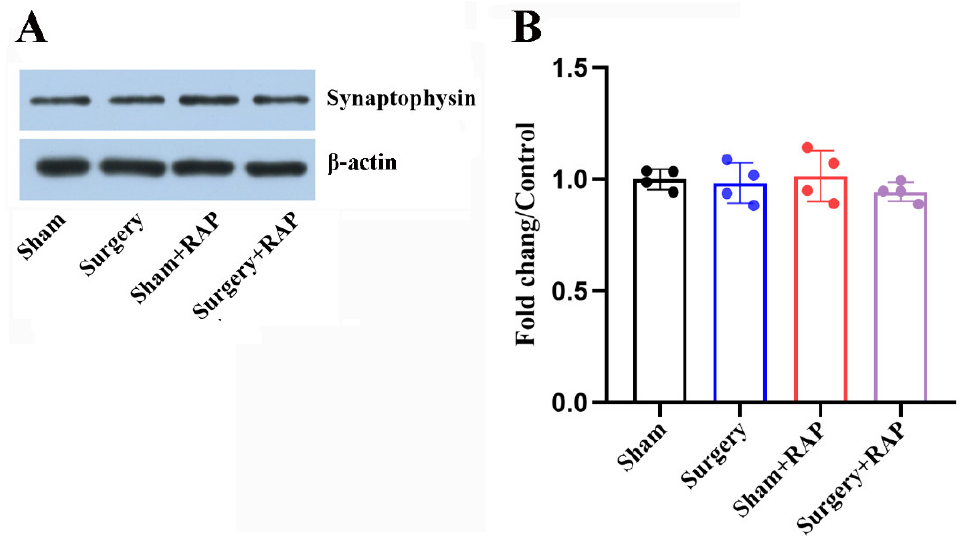
Figure 3. Surgery did not impact synaptic vesicle markers in hippocampal synaptosomes. ( A ) Representative immunoblots of synaptophysin in hippocampal synaptosomes. ( B ) No differences in synaptophysin levels were detected among the four groups (all p > 0.05). Values represent the mean ± SEM, n = 4 per group. RAP: rapamycin.